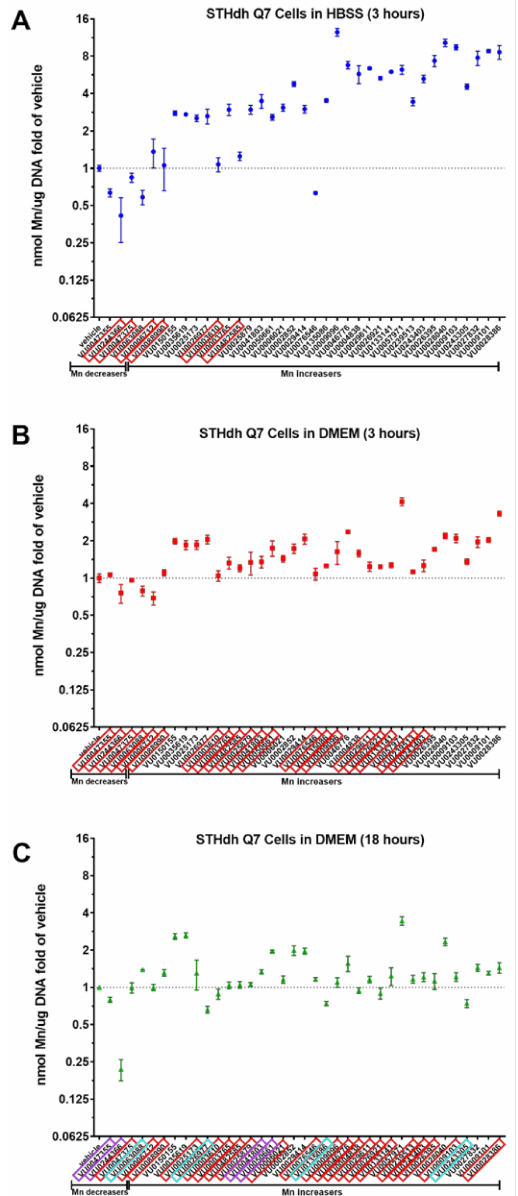
Figure 1. Small molecule modifiers of manganese have a tendency to lose their efficacy when exposed in culture media. A set of 37 small molecules identified to influence intracellular Mn in a high throughput screen (see reference 33), commonly referred to as the “Mn Toolbox”, were confirmed independently ( A ). A red box around each small molecule, identified using its assigned VU identity number (see reference 33), denotes non-significance as determined by Brown–Forsythe ANOVA and Welch’s ANOVA tests with Dunnett’s T3 multiple comparisons. The number of compounds that did not reach statistical significance increases when exposed in DMEM rather than HBSS ( B ). When incubated in media for 18 h ( C ), several small molecules had an impact on Mn when previously no statistically significant impact existed at 3 h (boxed in purple). Several small molecules changed directions (Mn-increaser to decreaser, or decreaser to increaser), which are denoted by a box in blue. Error bars represent standard deviation of three biological